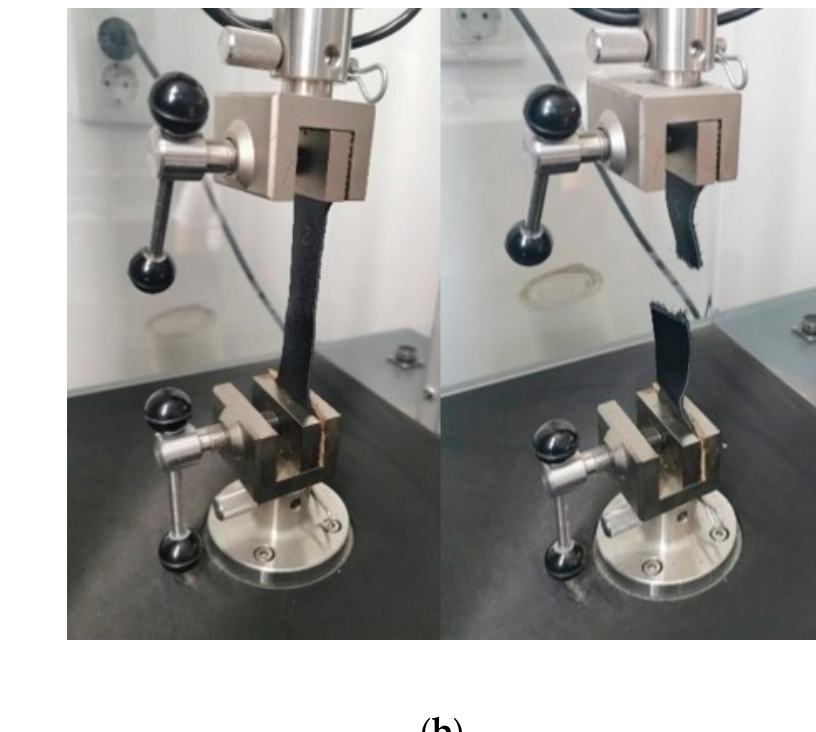
Figure 1. ( a ) Shape and dimensions of the unprocessed samples (S1); and ( b ) unprocessed sample position in the testing machine. Before and after testing.